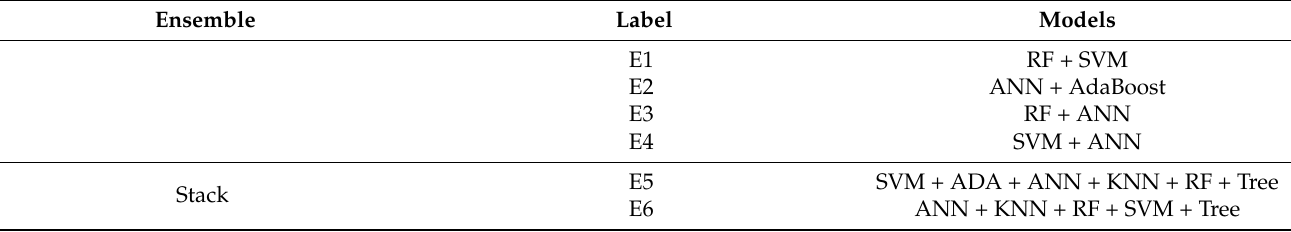
Table 4. Description of ensemble models developed.